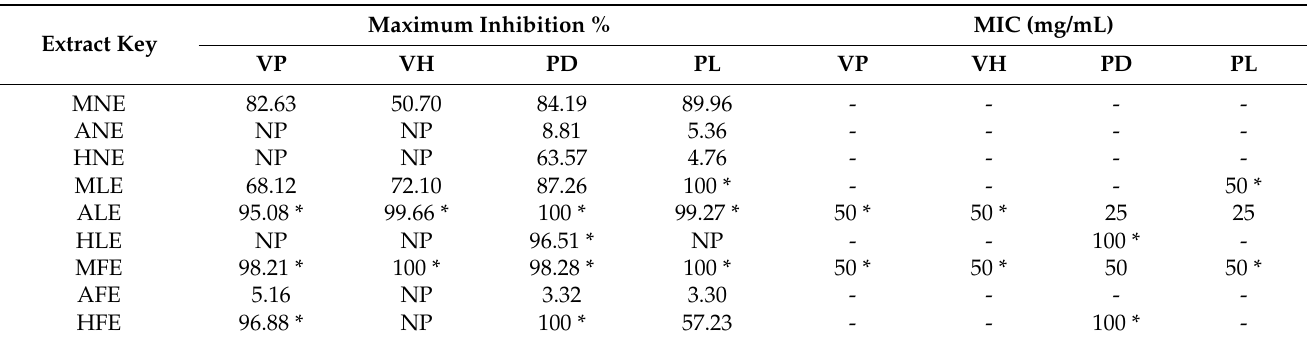
Table 1. Maximum antibacterial activity of the obtained extracts and their minimum inhibitory concentration.